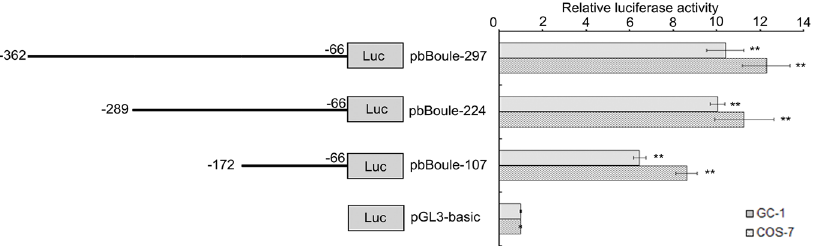
Fig 3. Identification of the core promoter in the b Boule gene. Left panel, functional deletion constructs of the b Boule 5' flanking region. Right panel, the luciferase activity of each deletion construct of the b Boule 5' flanking region. The deletion constructs were transiently transfected into GC-1 and COS-7 cell lines. Normalized luciferase activities are expressed as mean ± SEM of duplicates for a minimum of three experiments. All data were compared with the control group (pGL3-basic). ** indicates a significant difference (P <